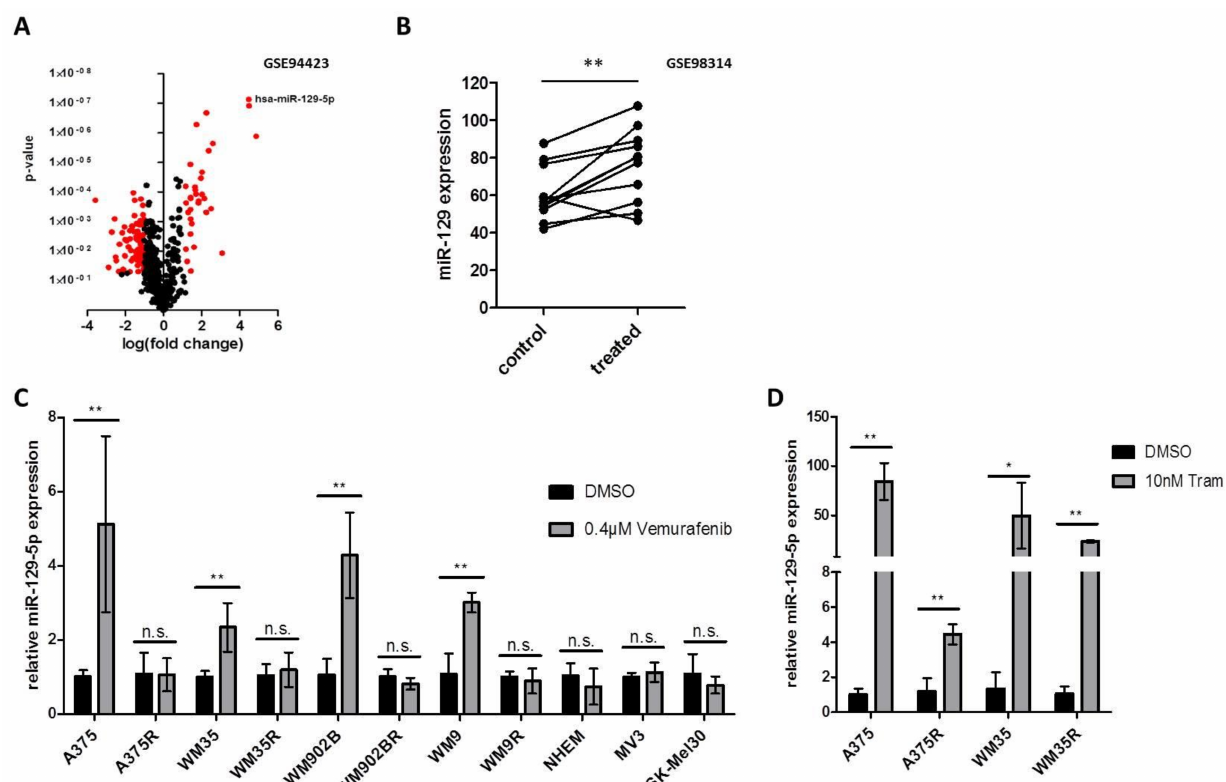
Figure 1. miR-129-5p expression is increased during BRAFi and MEKi treatment. ( A ) Volcano plot of miRNAs differentially expressed in BRAFi treated A375 cells vs. a group of three different conditions: A375 treated with DMSO and a resistant clone of A375 cells (A375R) treated with Vemurafenib or DMSO (GSE94423). Red dots represent significant differentially expressed miRNAs (log 2 fold change: ≥ 1; ≤− 1; p ≤ 0.05). ( B ) Analyses of the miR-129 expression in eleven BRAF mutated melanoma cell lines treated with DMSO (control), Dabrafenib or a combination of Dabrafenib and Trametinib (treated). Expression data are shown as cubic spline function normalized values. ( C ) qRT-PCR analyses of miR-129-5p after BRAFi (0.4 µ M Vemurafenib, 24 h) in BRAF mutation associated cell lines (A375, WM35, WM902B, WM9), BRAFi resistant cell lines (A375R, WM35R, WM902BR, WM9R), normal human epidermal melanocytes (NHEM) and BRAF wildtype melanoma cell lines (MV3, SK-MEL30). ( D ) qRT-PCR for miR-129-5p expression after MEK inhibition by 10 nM Trametinib for 48 h on parental sensitive (A375, WM35) and the corresponding resistant BRAF mutated cell lines (A375R, WM35R). Bars represent average ± standard deviation of at least three independent experiments. * p ≤ 0.05; ** p ≤